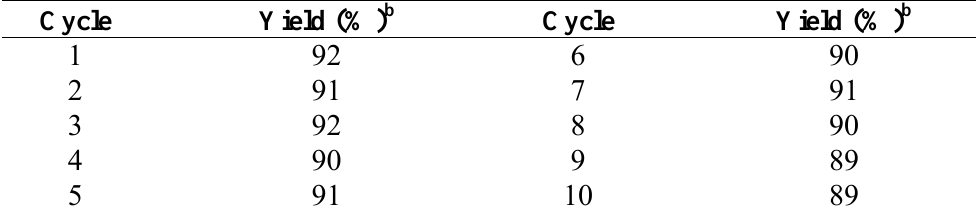
Table 2. Ionic liquid and catalyst recycling in the acetylation of benzyl alcohol.